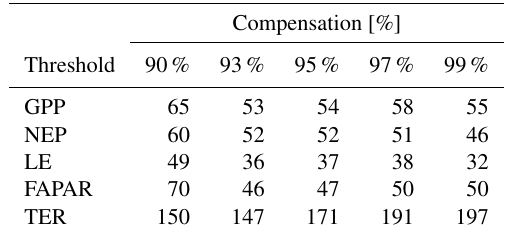
Table A1. Compensation effects of the integrated hydrometeoro- logical events (spring and summer) are not sensitive to varying the threshold for extreme event detection between 93% and 99% (7% and 1% of extreme data in each spatiotemporal segment). A slight tendency towards more pronounced compensation effects can be seen for the 90% threshold. Such a kind of enhancing the positive response is expected for lower thresholds, as the hydrometeorolog- ical conditions are not perceived as “extreme” anymore.